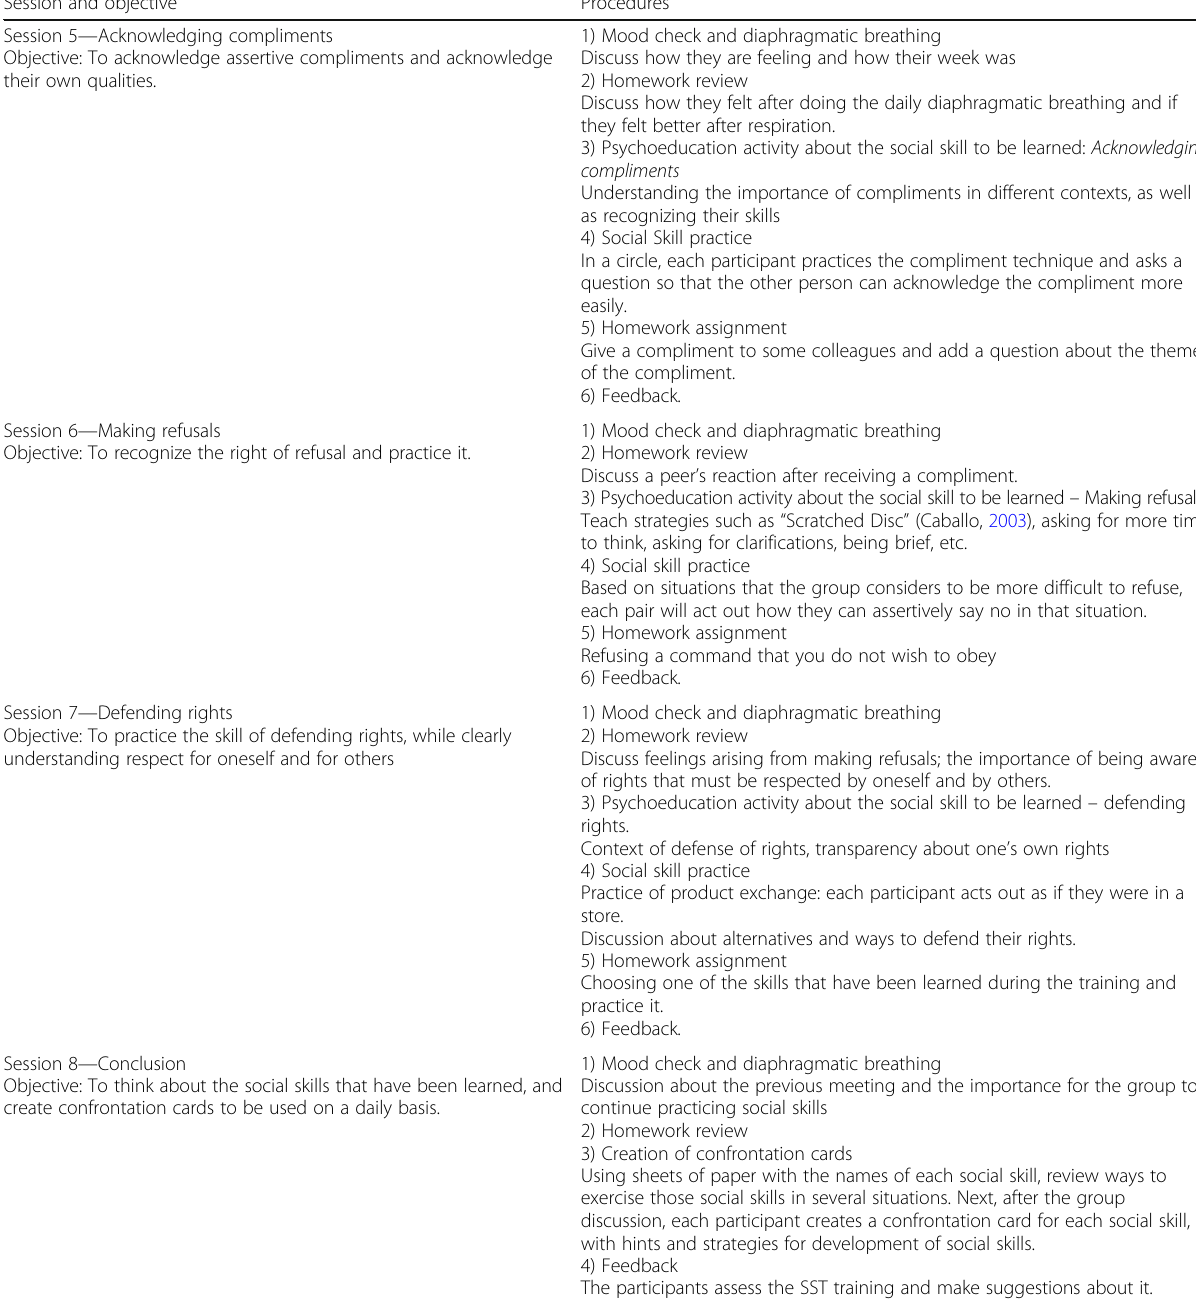
Table 2 Description of sessions and procedures (Continued) Session and